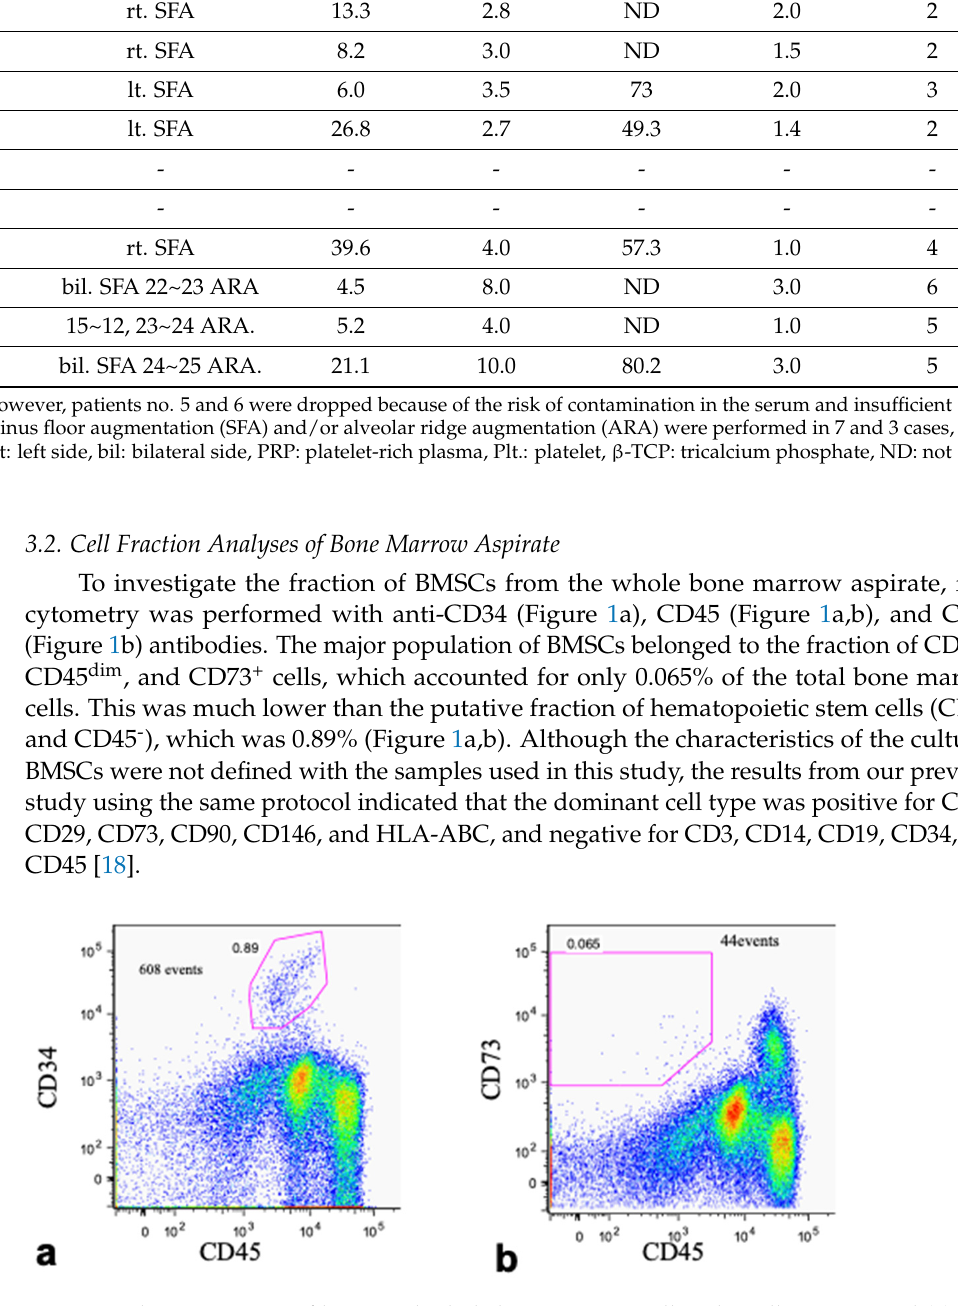
Table 1. Summary of patient information.